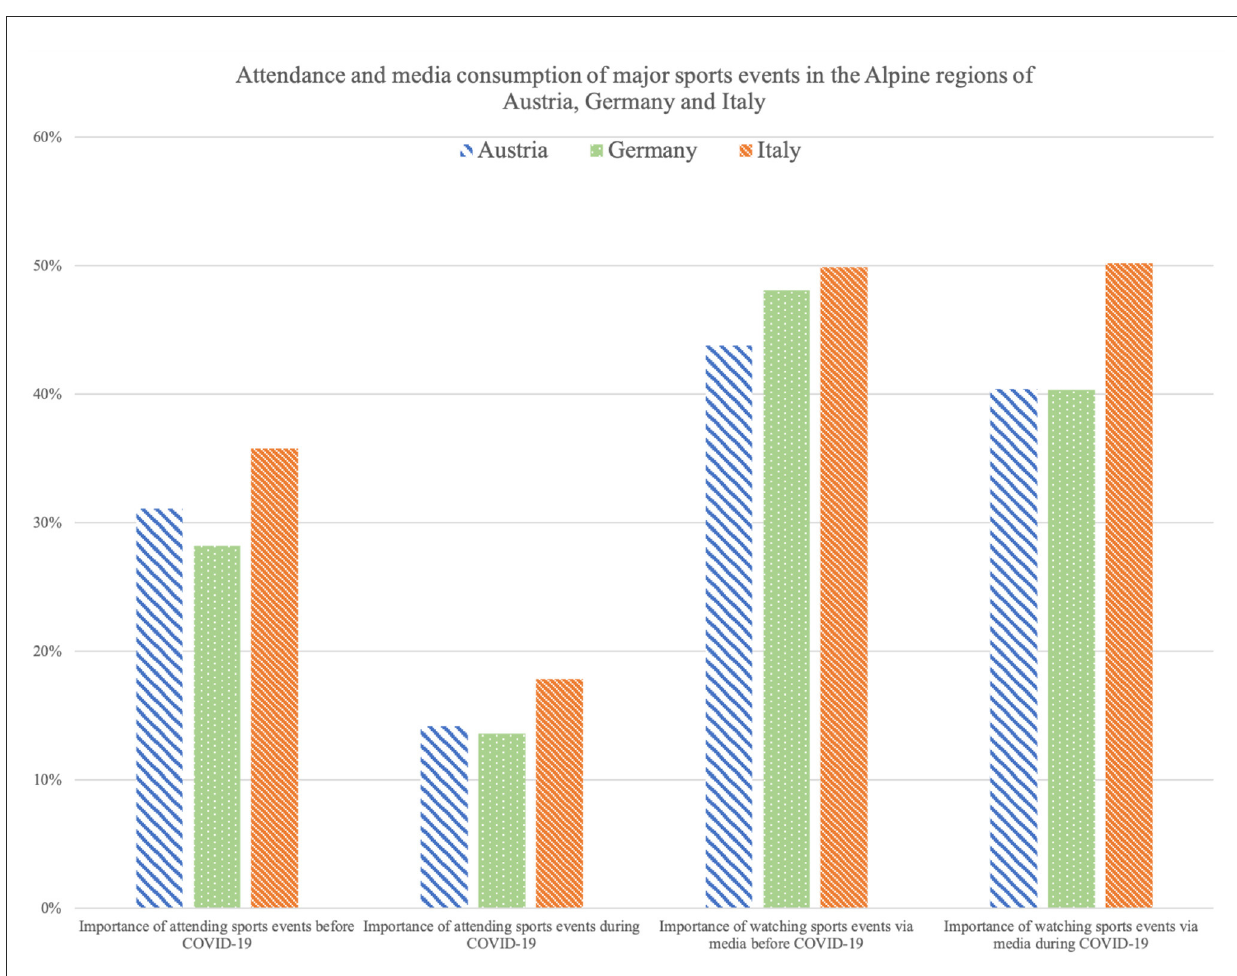
FIGURE1 Self-reported importance of attending (onsite) and watching ( via media) major sports events before and during COVID-19 in the Alpine regions of Austria, Germany, and